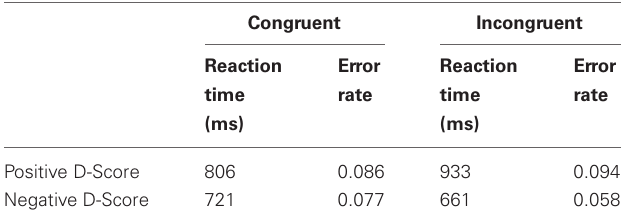
Table A1 | Across-subjects average error rates and across-subjects average of within-subject median reaction